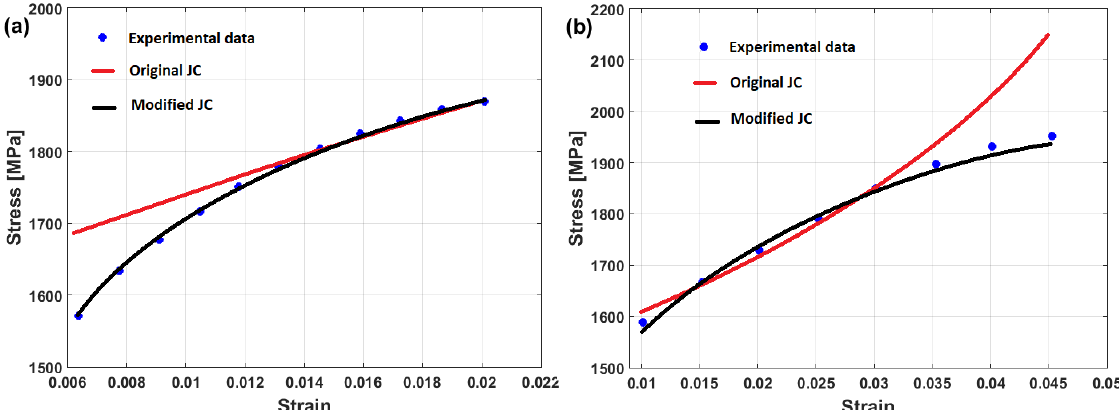
Figure 47. Experimental stresses (markers) compared to predicted stresses (solid lines) for SWRH82B steel alloy at a quasi-static strain rate and room temperature for circular wire with diameters ( a ) 4.2 mm and ( b ) 5.2 mm.